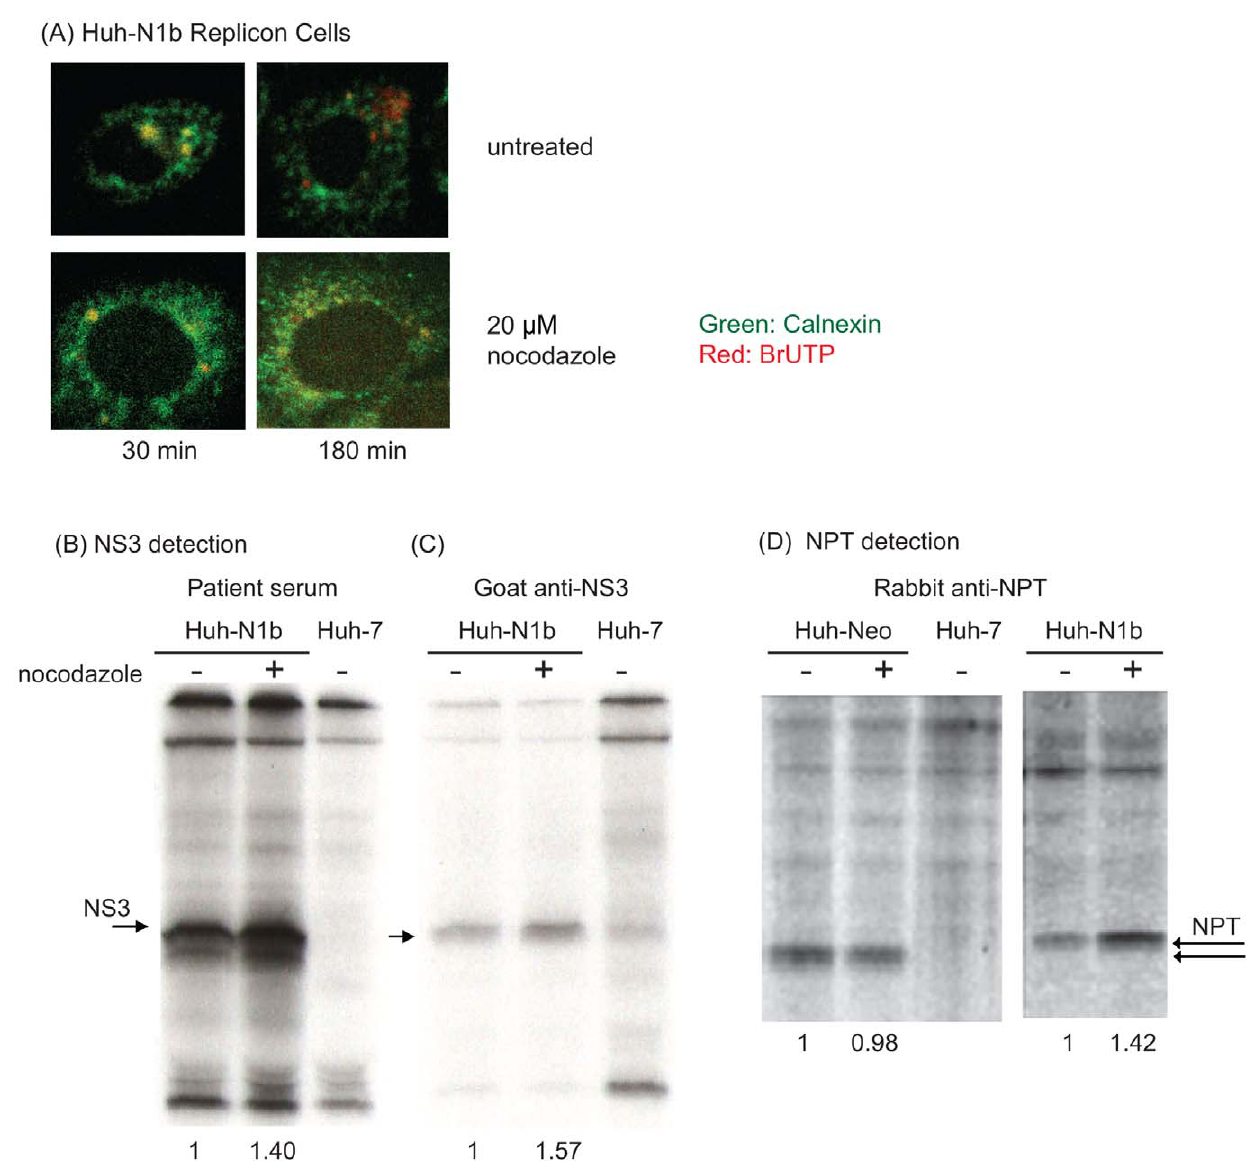
Figure 2. Increase in replicon RNA translation in nocodazole-treated HCV replicon cells. Huh-N1b cells was pre-treated with 20 m M nocodazole for 4 hours and then labeled with BrUTP or with 35 S-Methionine. (A) The BrU-labeled RNA remained colocalized with calnexin (an ER amrker) even after 180 min. (B–D) Proteins were immunoprecipitated with (B) HCV patient serum, (C) Goat anti-NS3 antibody, or (D) Rabbit anti-NPT antibody. The immunoprecipitated products were detected by autoradiography. The nocodazole-pretreated Huh-N1b cells showed about 50% increase in NS3 and NPT translated from replicon RNA, whereas NPT translation in the Huh-Neo control cells was not affected by the nocodazole